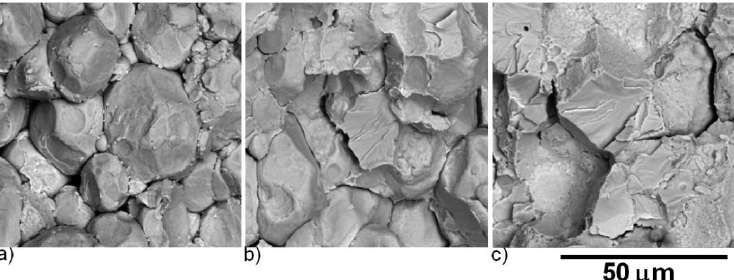
Figure 14. SEM (BSE) micrographs of fracture surfaces of SPS compacted Fe28Al from the initial powder sintered at ( a ) 900 °C, ( b ) 1000 °C, and ( c ) 1100 °C.